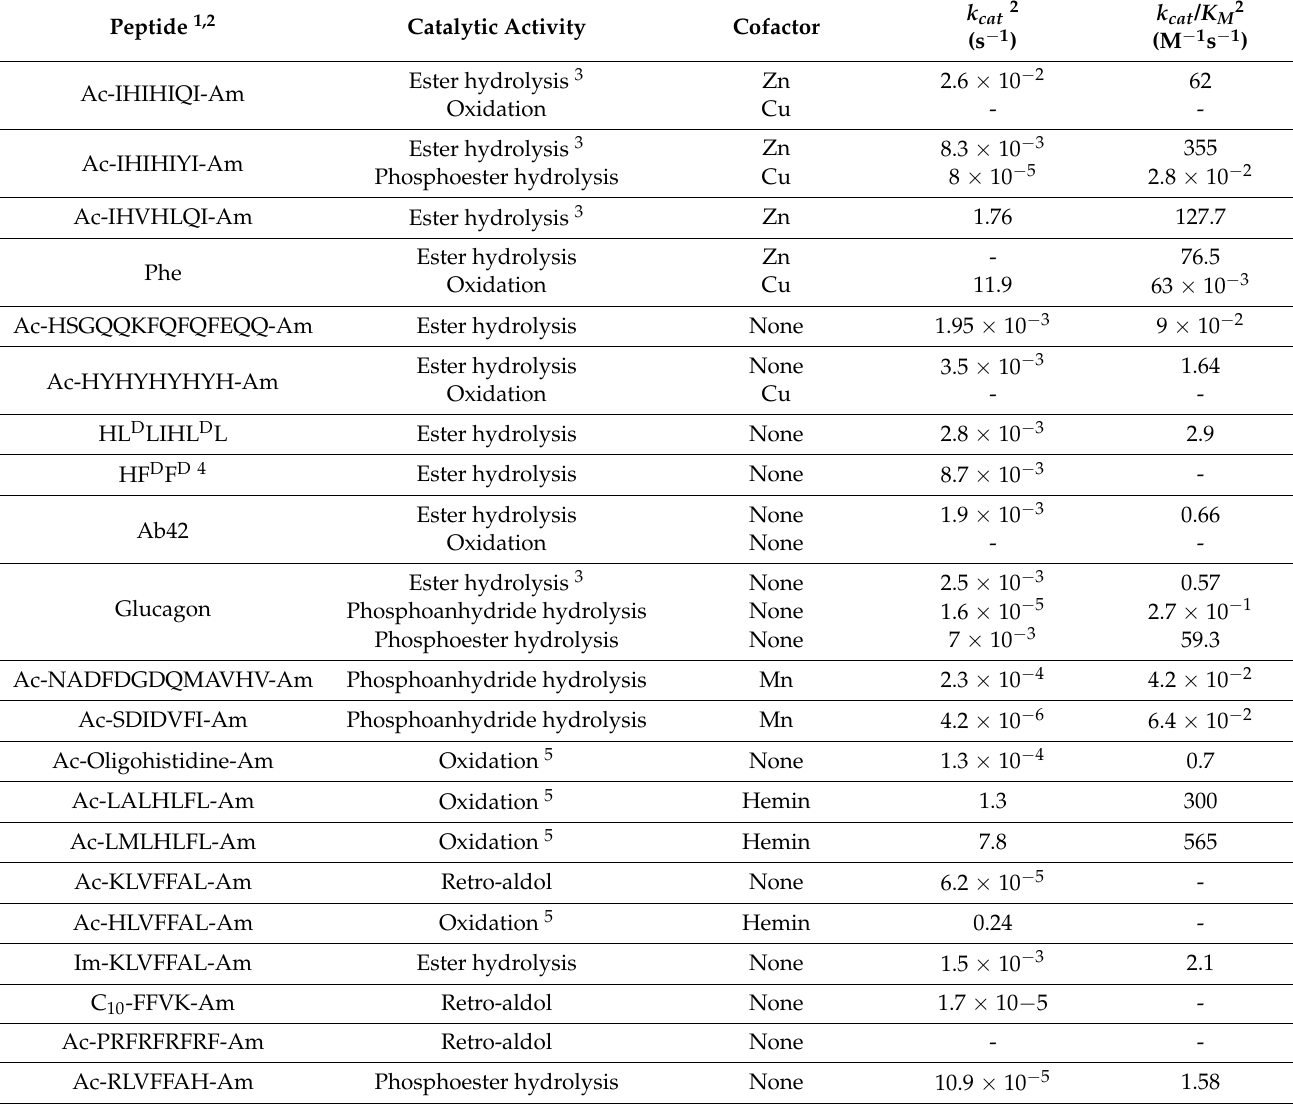
Table 1. List of peptides and their specific catalytic activities in the amyloid